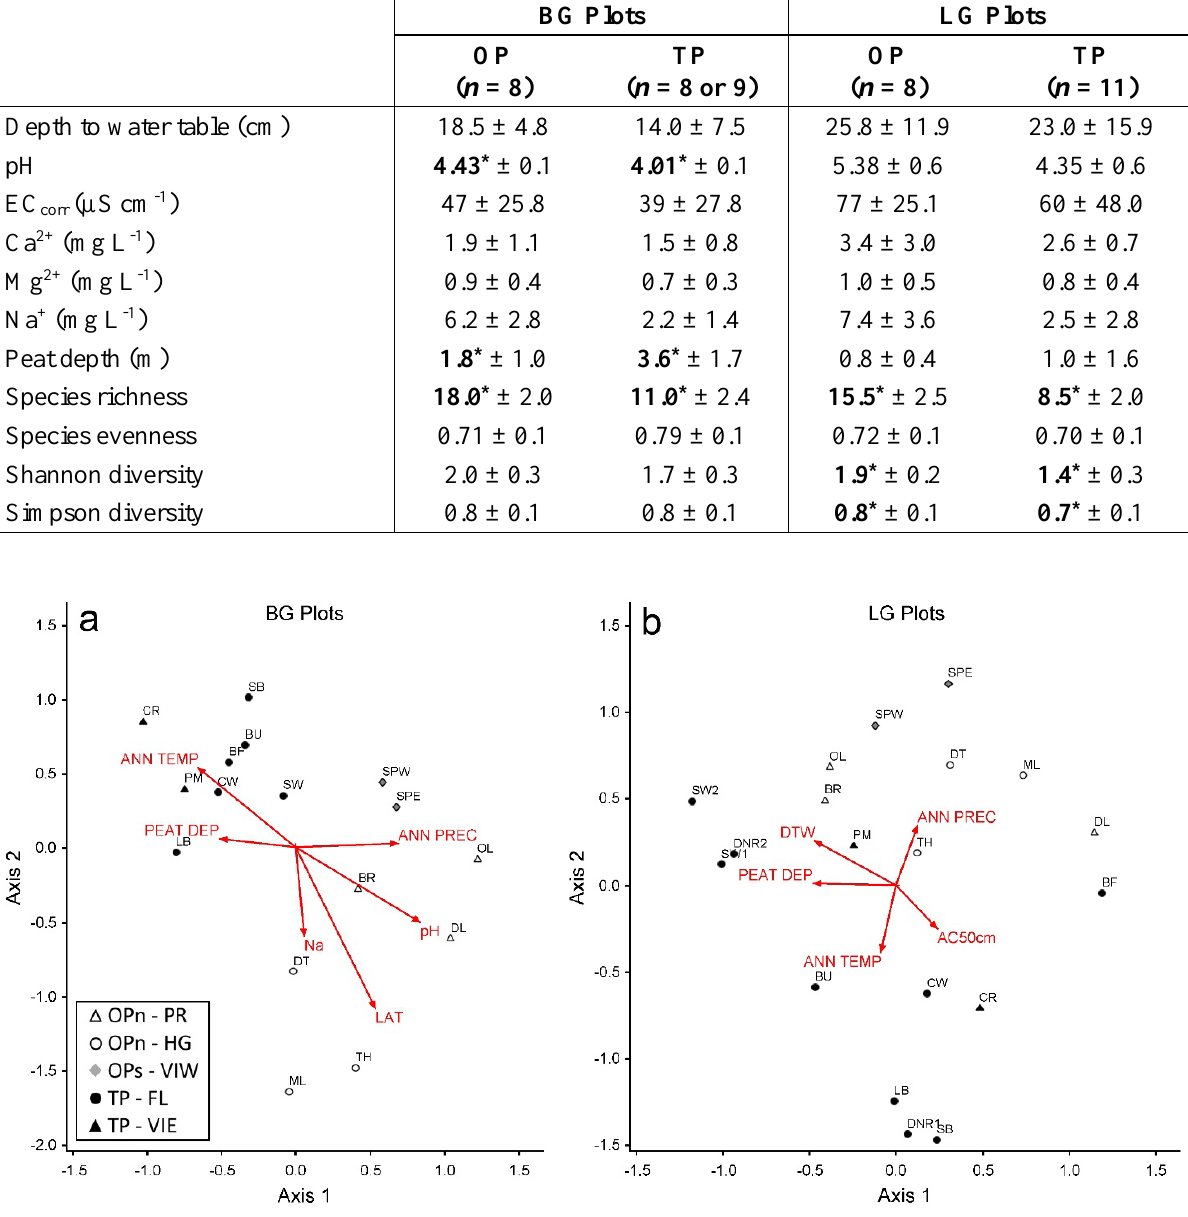
Figure 6. Non-metric multidimensional scaling (NMS) ordination and joint plot of plant species composition and abundance (average of the two paired plots) and environmental variables (for primary transect only) in BG plots and LG plots. The BG plot data for the DNR site is not included because hydrochemistry and water level data are missing. See Figure 1 for site codes. The vector arrow lengths are proportional to the strength of the correlation between the environmental variables and vegetation plot dissimilarities. Vector scaling: 100 %. Joint plot cutoff r 2 value: 0.200; variables with correlations below 0.200 are not displayed on the biplots. ANN TEMP is mean annual temperature, ANN PREC is mean annual precipitation, LAT is latitude, PEAT DEP is peat depth, Na is Na + concentration, DTW is depth to water table, and AC50 is fraction of inorganic material at 50 cm below the soil